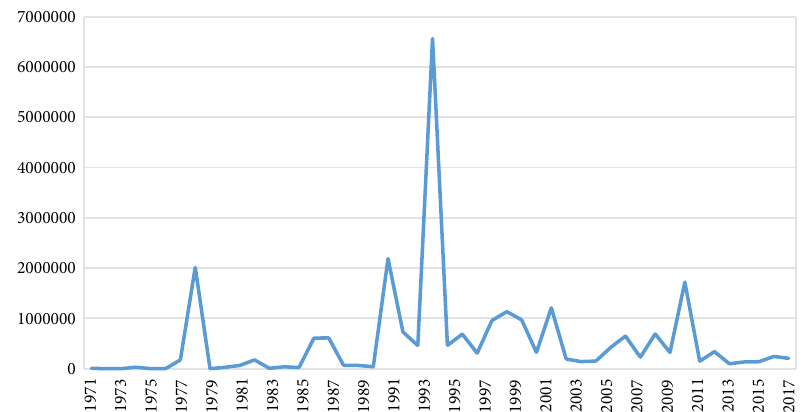
Figure 1. The evolution of the total number of people affected by epidemics from 1971 to